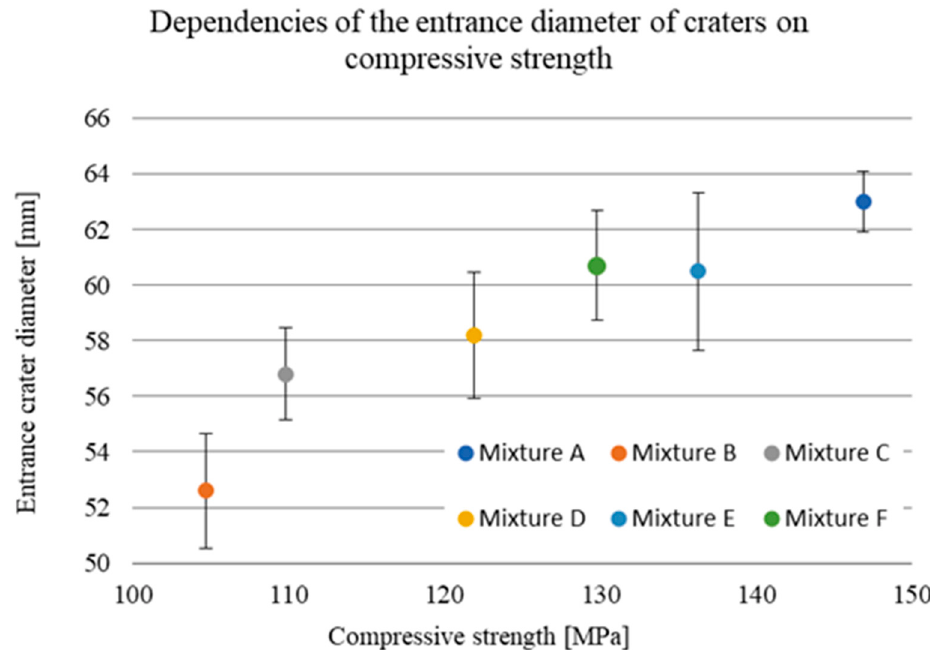
Figure 10. Entrance crater diameter versus compressive strength.